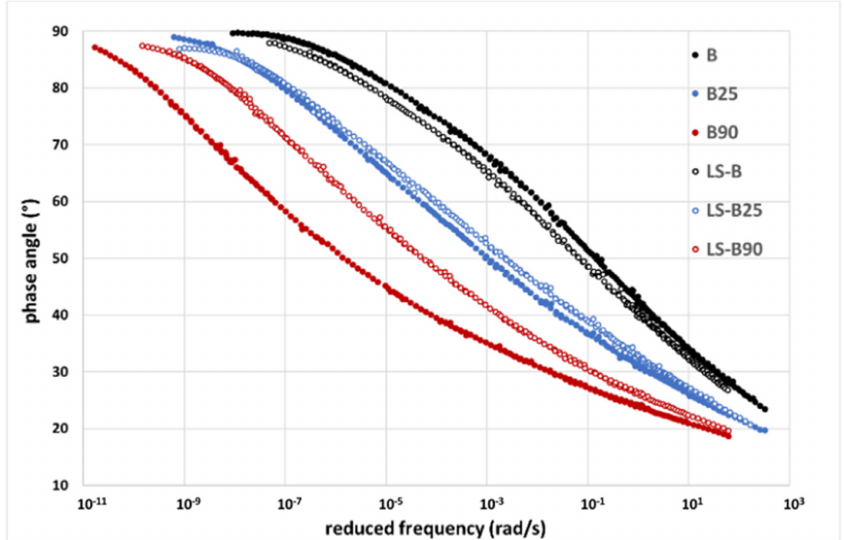
Figure 3. Phase-angle master curves for binders B and LS-B before and after different levels of aging. Reference temperature 0 ◦ C.